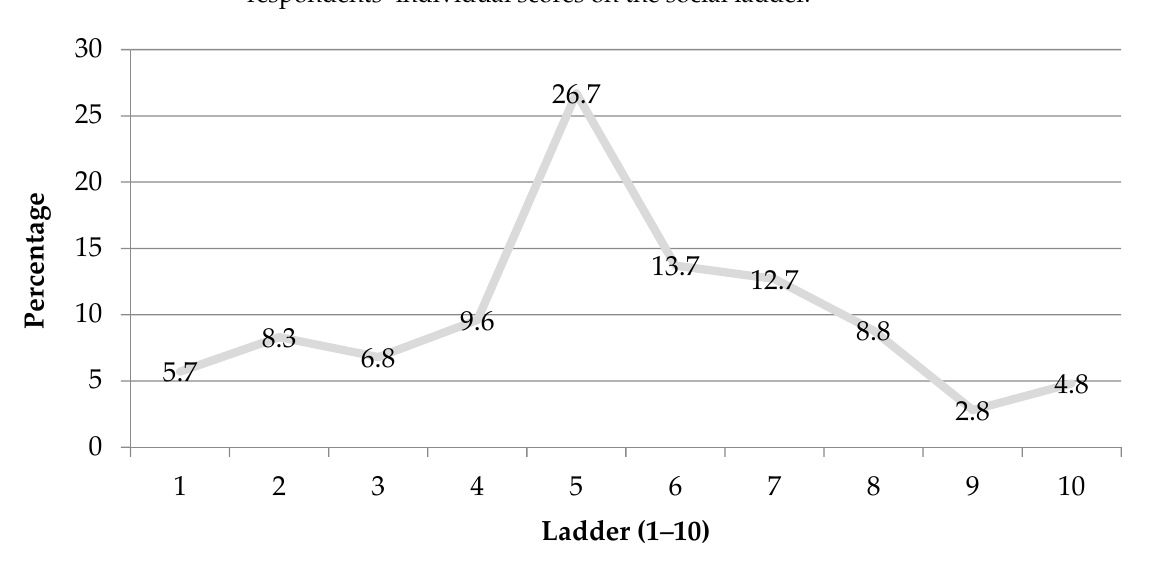
Figure 1. Subjective social status.